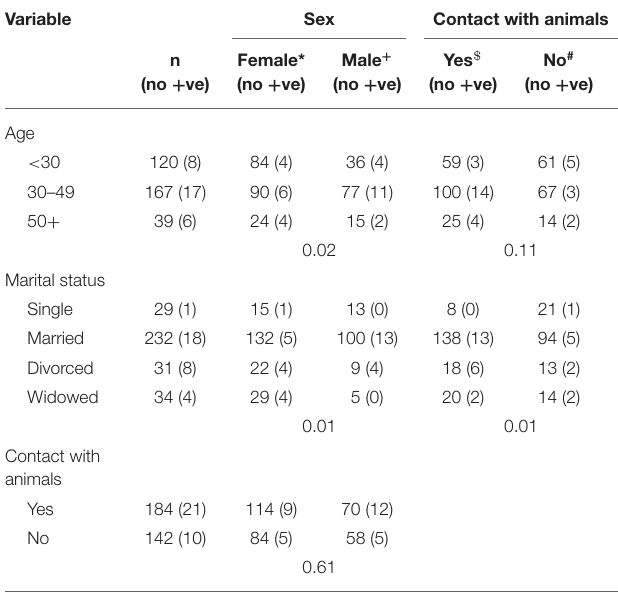
TABLE 6 | Cross tabulation of male and female participants infected with Cryptosporidium according to age, marital status, and contact with animals in adult HIV population in Namwala District ( n =